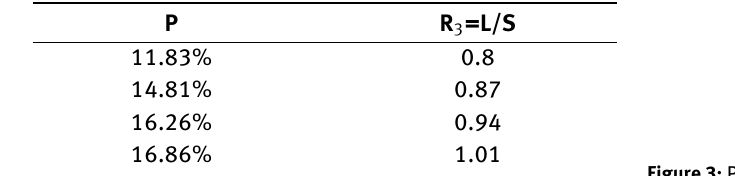
Table 2: values of P and R3